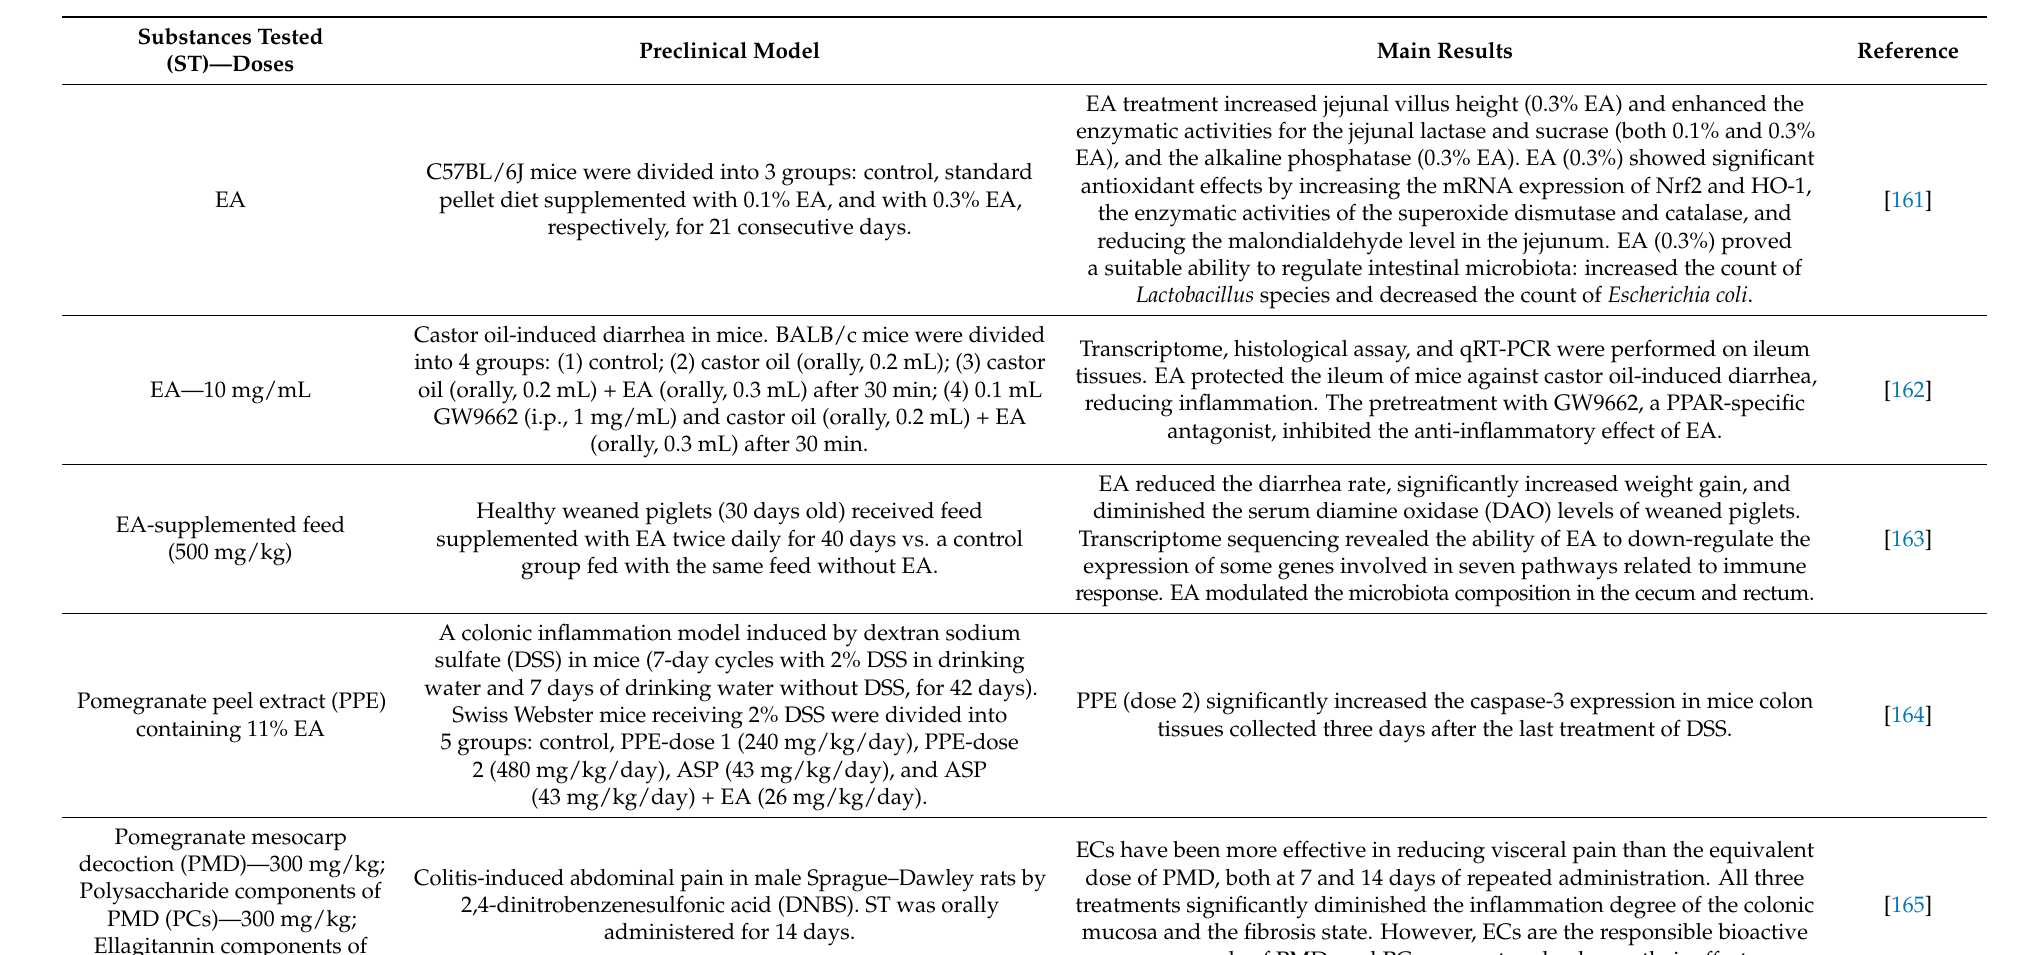
Table 2. Preclinical studies attesting the antioxidant, anti-inflammatory, and anti-tumor effects of ellagitannins, ellagic acid, or their metabolites at the intestinal